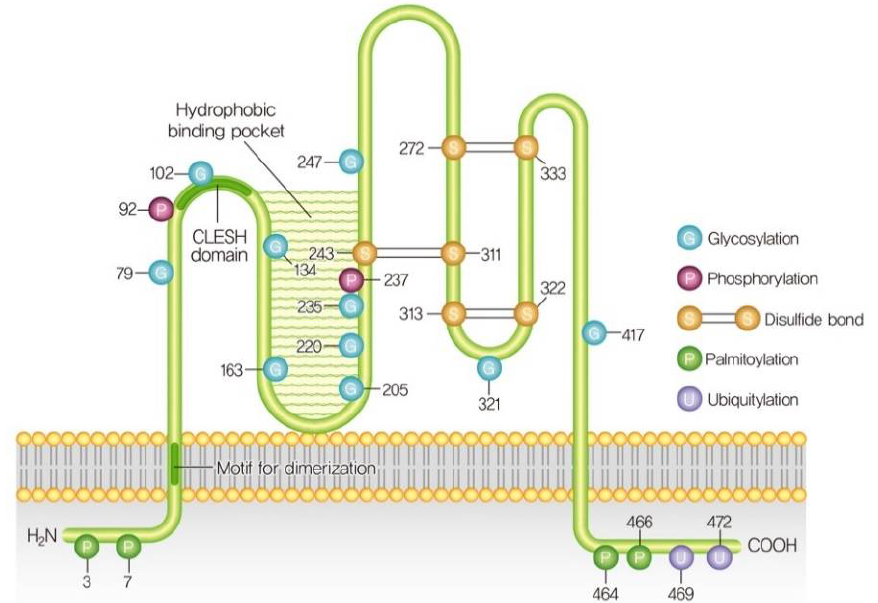
Figure 1. CD36 structure and post-translational modifications. (Adopted from Ref: [28], copyright 2020 © Korea Diabetes Association) .